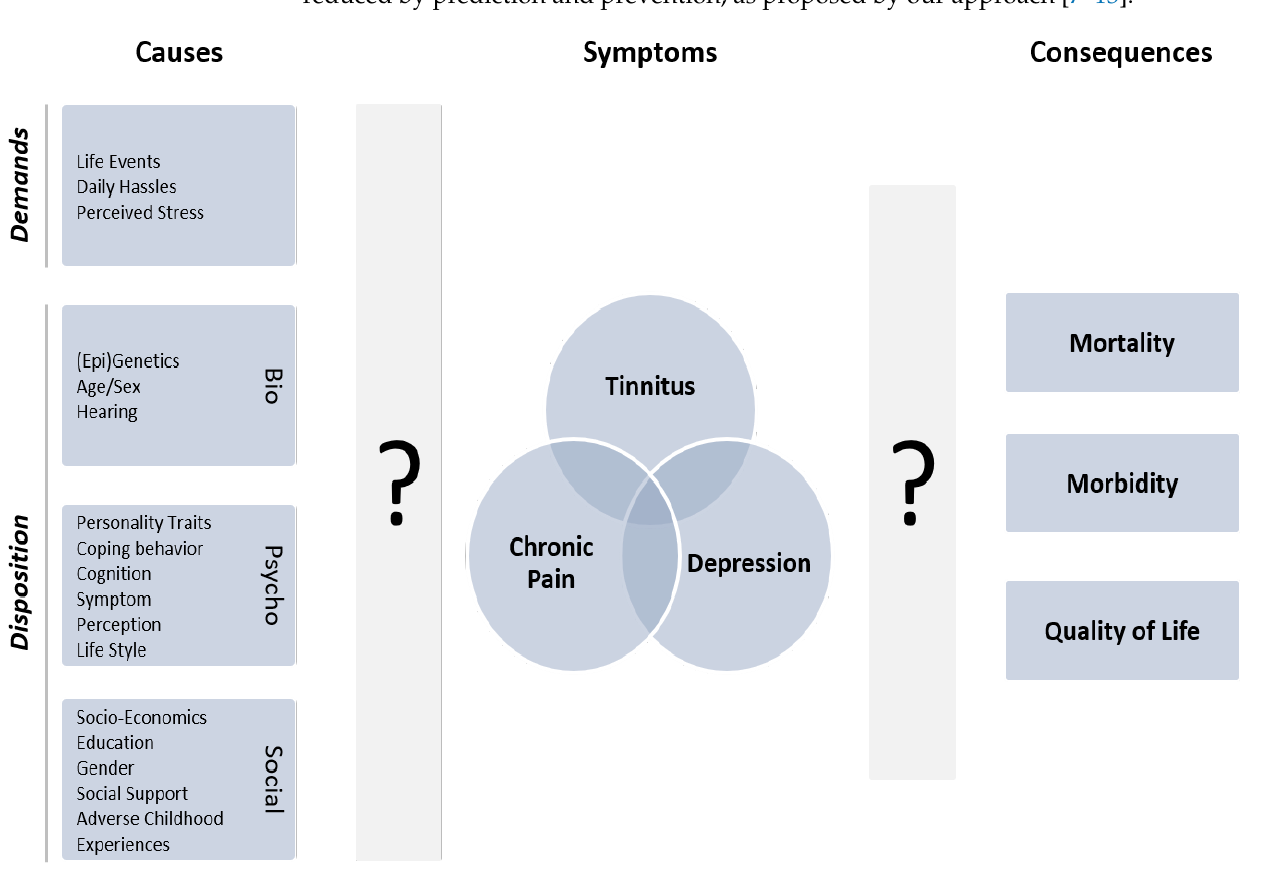
Taken together, tinnitus, depression, and chronic pain affect at least a quarter of the European population, and have a cumulated societal cost between EUR 400 billion and over EUR 700 billion annually in the European Union. These costs can be significantly reduced by prediction and prevention, as proposed by our approach [7–13].